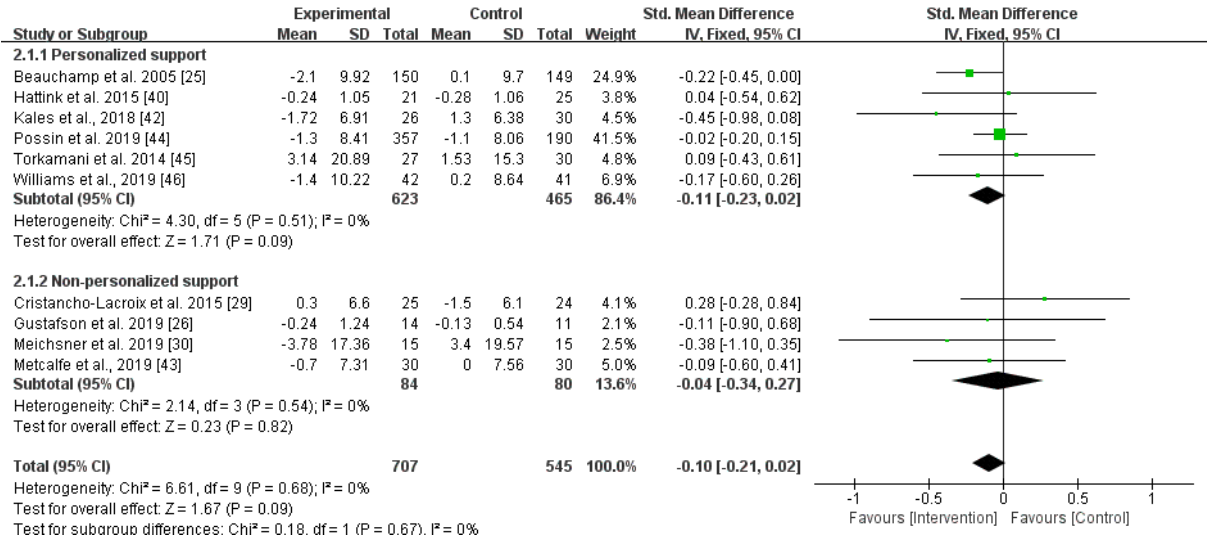
Figure 4. The effect of internet-based supportive interventions on caregiver burden.